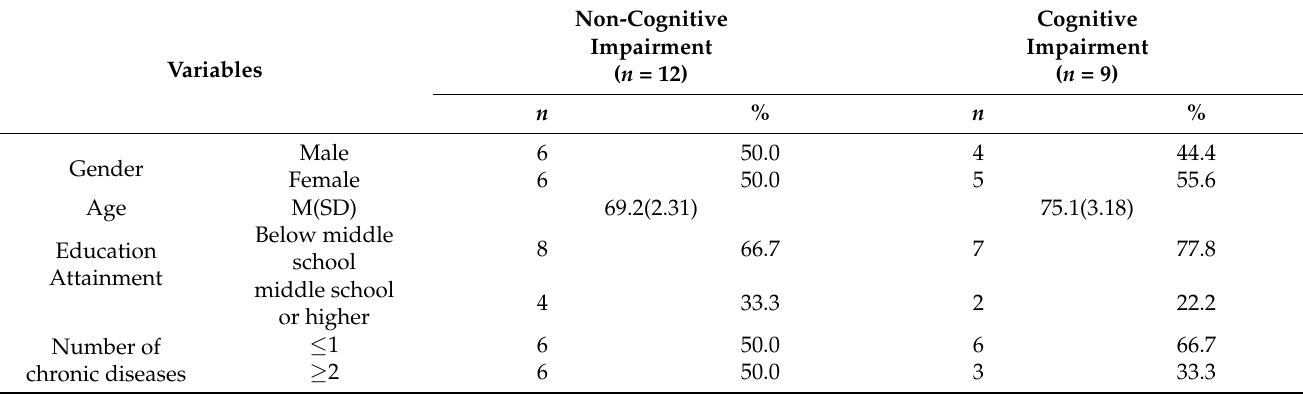
Table 1. Characteristic information of experimental